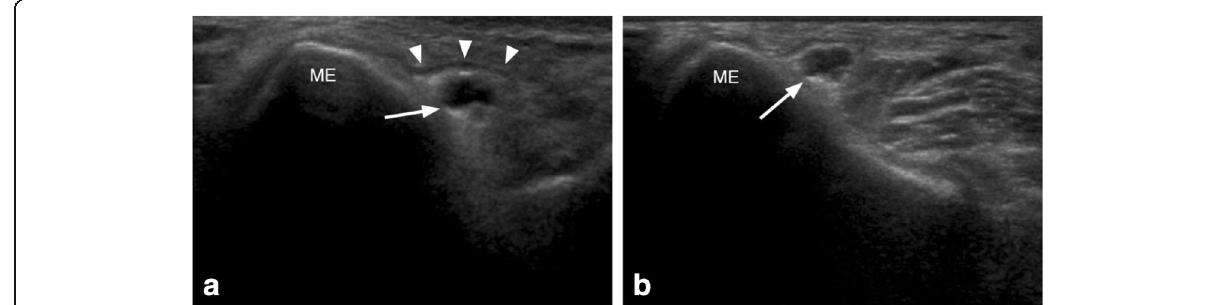
Fig. 3 The ulnar nerve location for different elbow positions. ( a ) anatomy of the ulnar nerve. ( b ) ulnar nerve by ultrasound while elbow and upper limb in rest